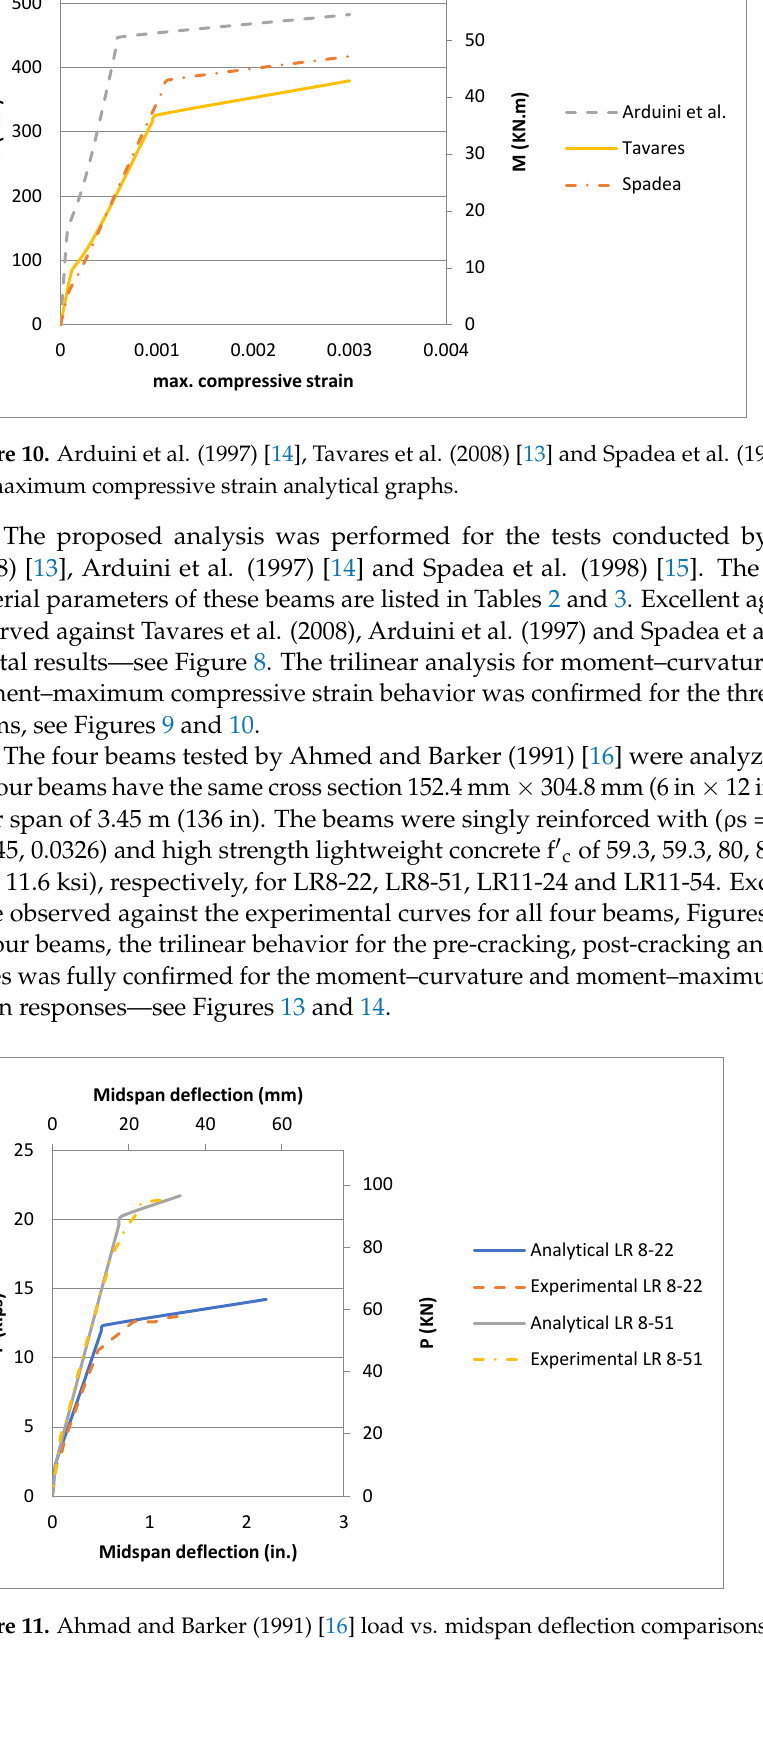
Figure 11. Ahmad and Barker (1991) [16] load vs. midspan deflection comparisons for LR 8